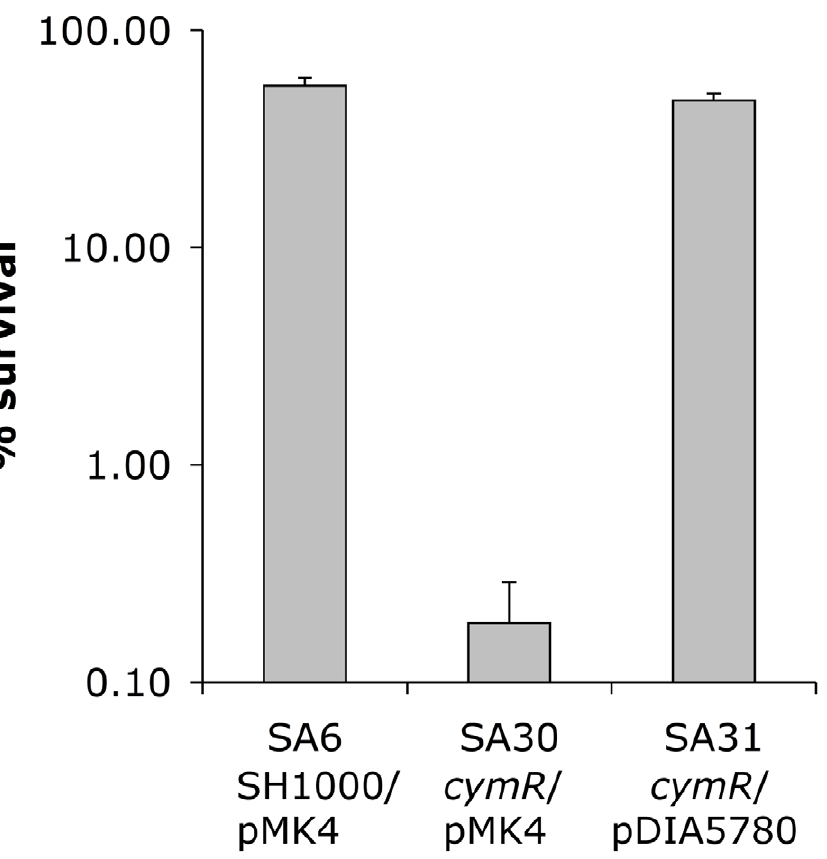
Figure 2. Oxidative stress sensitivity of a S.aureus D cymR mutant. Viability of SA6 (SH1000/pMK4), SA30 ( D cymR /pMK4) and SA31 ( D cymR / pDIA5780) was tested. Exponential-phase cells grown in TSB medium with 2 mM cystine were treated for 1 h with 20 mM H 2 O 2 and plated on BHI. Results represent the mean values for survival with standard deviations and are representative of at least two independent experiments.